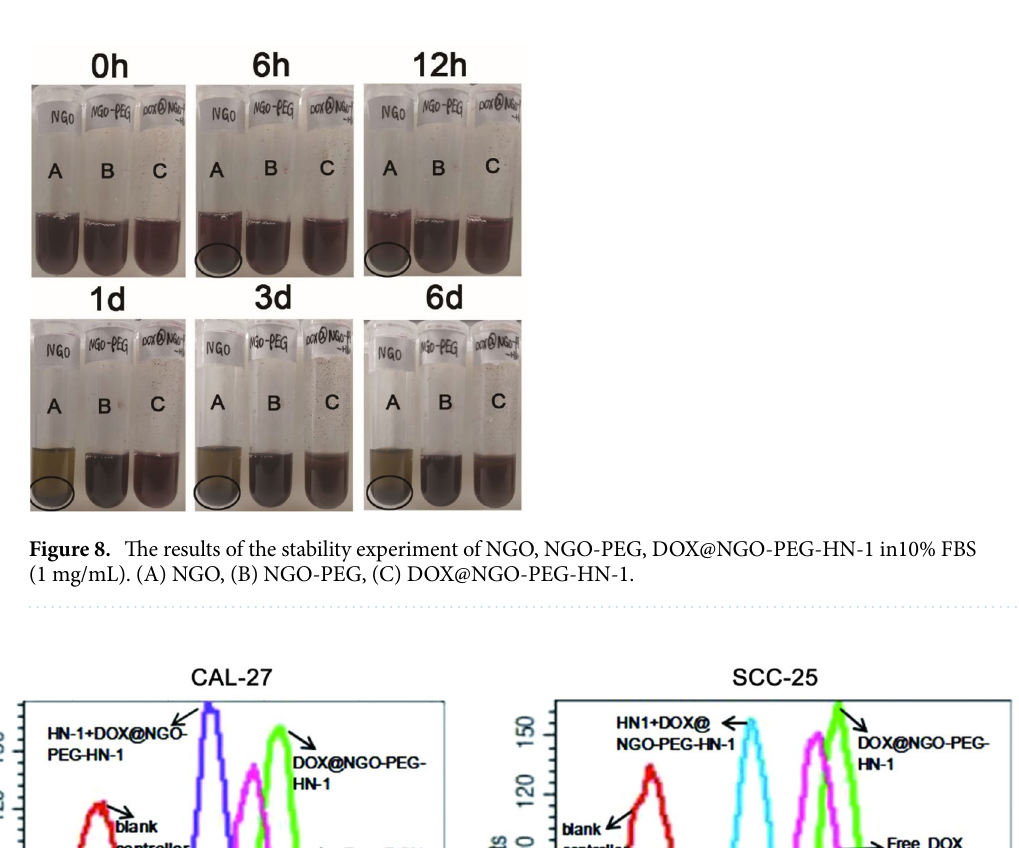
Figure 7. The results of the stability experiment of NGO, NGO-PEG, DOX@NGO-PEG-HN-1 in water (1 mg/ mL). (A) NGO, (B) NGO-PEG, (C) DOX@NGO-PEG-HN-1.